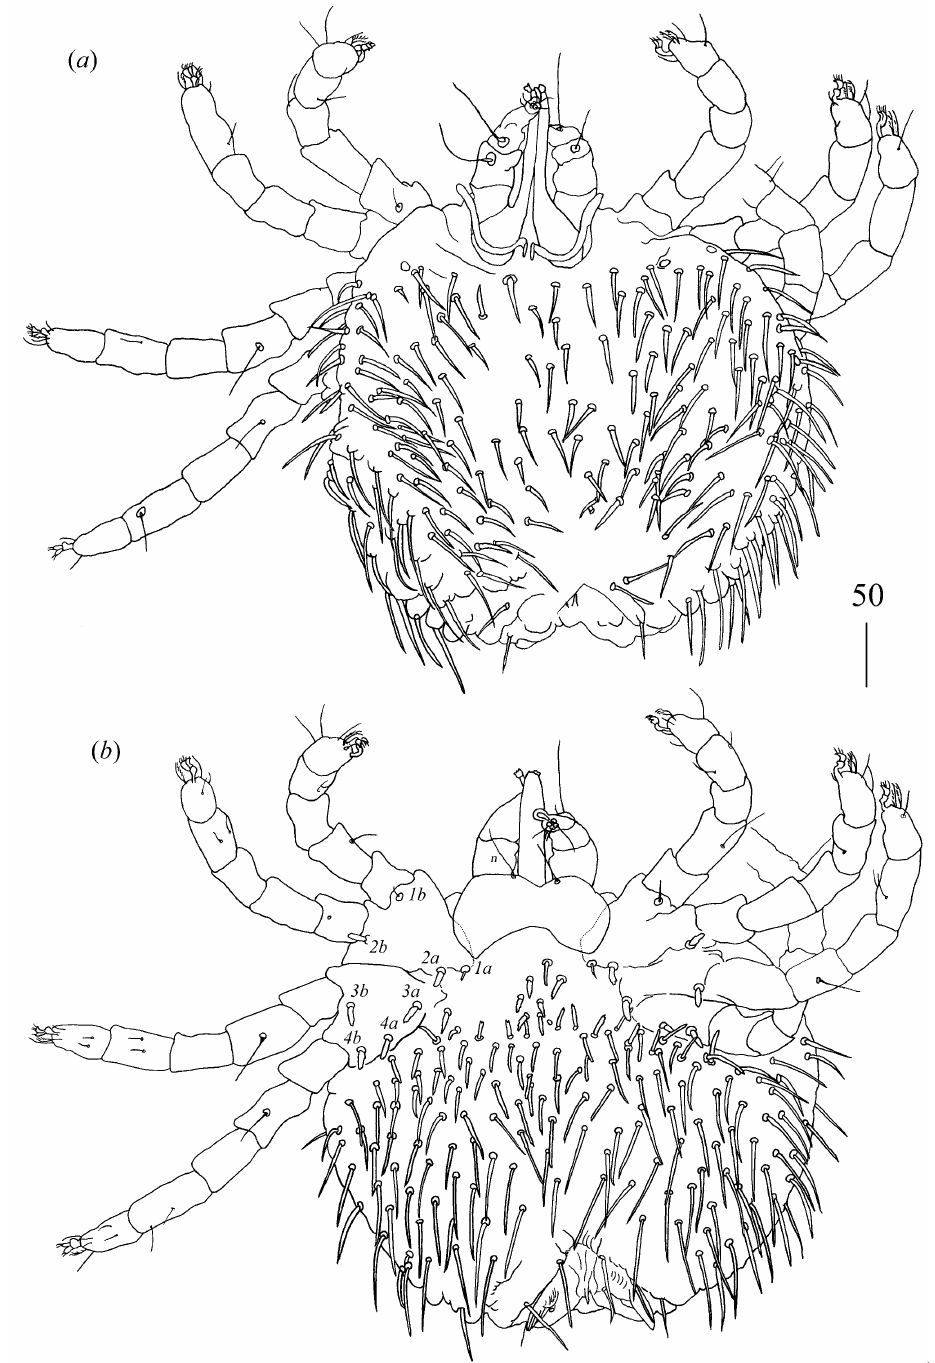
Figure 12. Geckobia treutleri sp. n. female: ( a ) in dorsal view; ( b ) in ventral view. Scale bar represents µm. Geckobia unica sp. n. (Figure